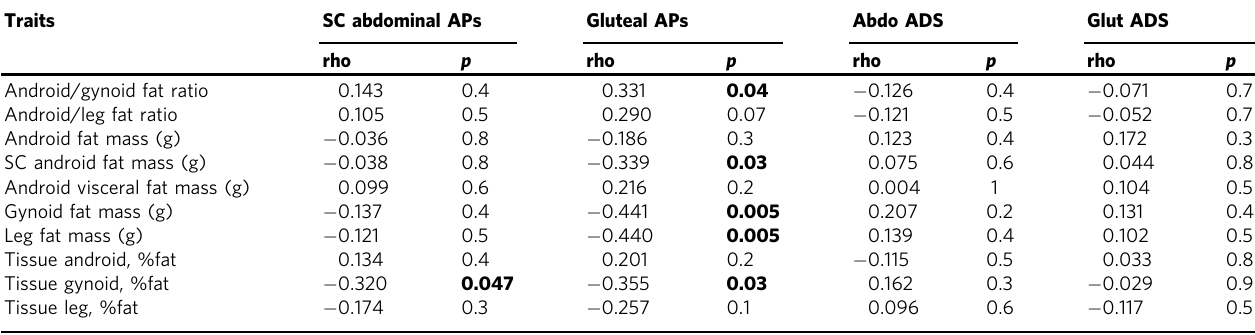
Table 2 Partial correlations (Spearman ’ s) of measures of body-fat distribution (DXA), with RSPO3 mRNA levels from abdominal and gluteal adipose tissue fractions from 43 women, adjusted for age, % total fat mass and menopause status. Traits SC abdominal APs Gluteal APs Abdo ADS Glut